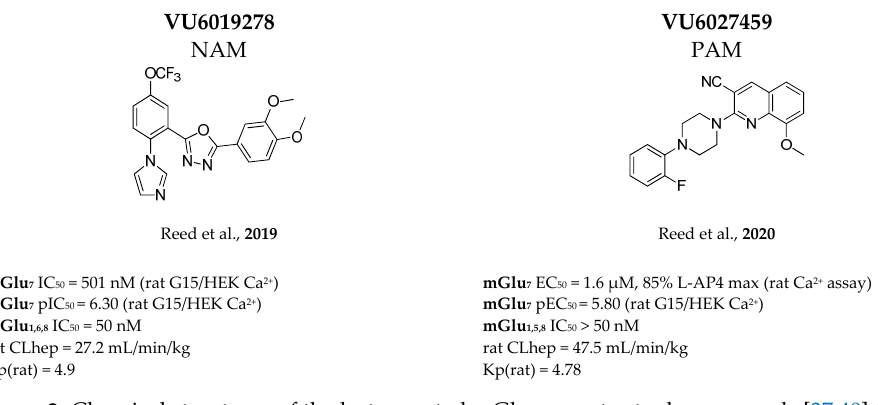
Figure 2. Chemical structures of the last reported mGlu 7 receptor tool compounds [37,40] (NAM— negative allosteric modulator; PAM—positive allosteric modulator). EC 50 —effective concentration 50; IC 50 —inhibitory concentration 50; assay type indicated in parenthesis; rat CL hep—predicted hepatic clearance in rat; Kp(rat)—rat brain/plasma ratio.